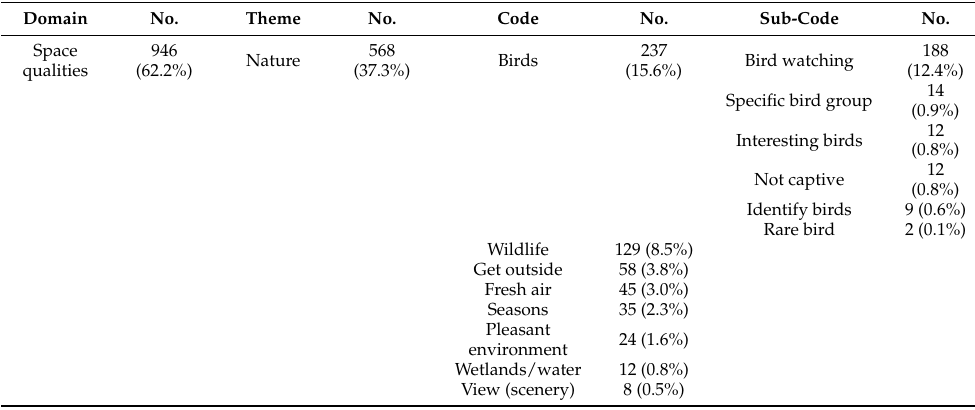
Table 1. Recalled participant motivations to visit UK wetland visitor centres from n = 365 participant responses to the question “What are your main reasons for visiting a WWT Wetland Centre?” via an online survey. The number of assigned meaning units (MUs) per domain, theme or code are presented along with the percentage of total MUs for the question ( n =